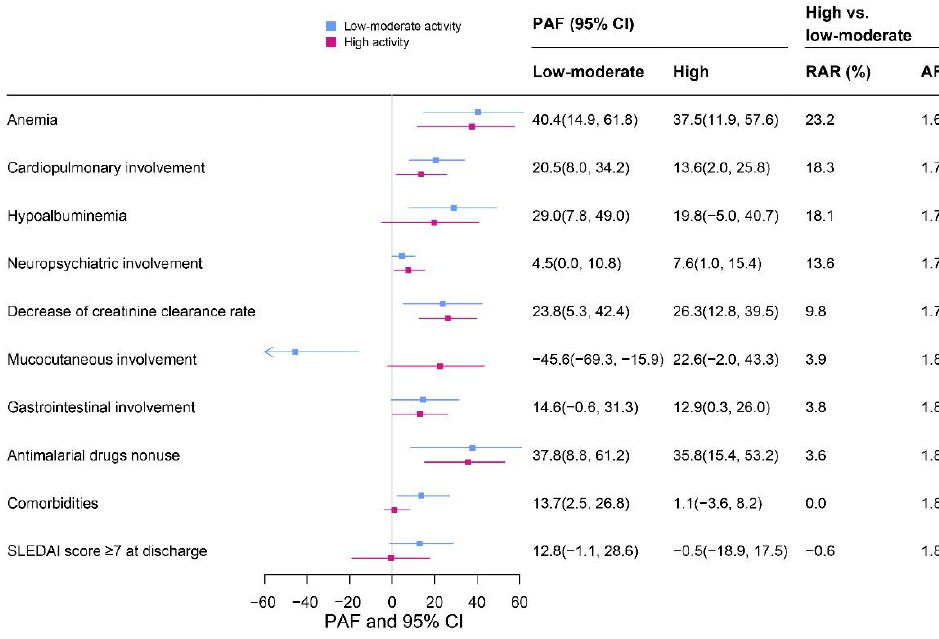
Figure 2. The individual population attributable fraction (PAF), relative attributable risk (RAR) and adjusted rate ratio (ARR) of risk factors in low–moderate activity and high activity groups in patients with SLE. The PAF was adjusted for sex (male = 1, female = 0), age (continuous), SLEDAI score on admission (continuous), comorbidities (yes = 1, no = 0, except for comorbidities), glucocorticoids treatment (yes = 1, no = 0) and immunosuppressive treatment (yes = 1, no = 0). Table 3. The population attributable fraction (PAF), relative attributable risk (RAR) and adjusted rate ratio (ARR) for the combination of risk factors in low–moderate activity and high-activity of patients with